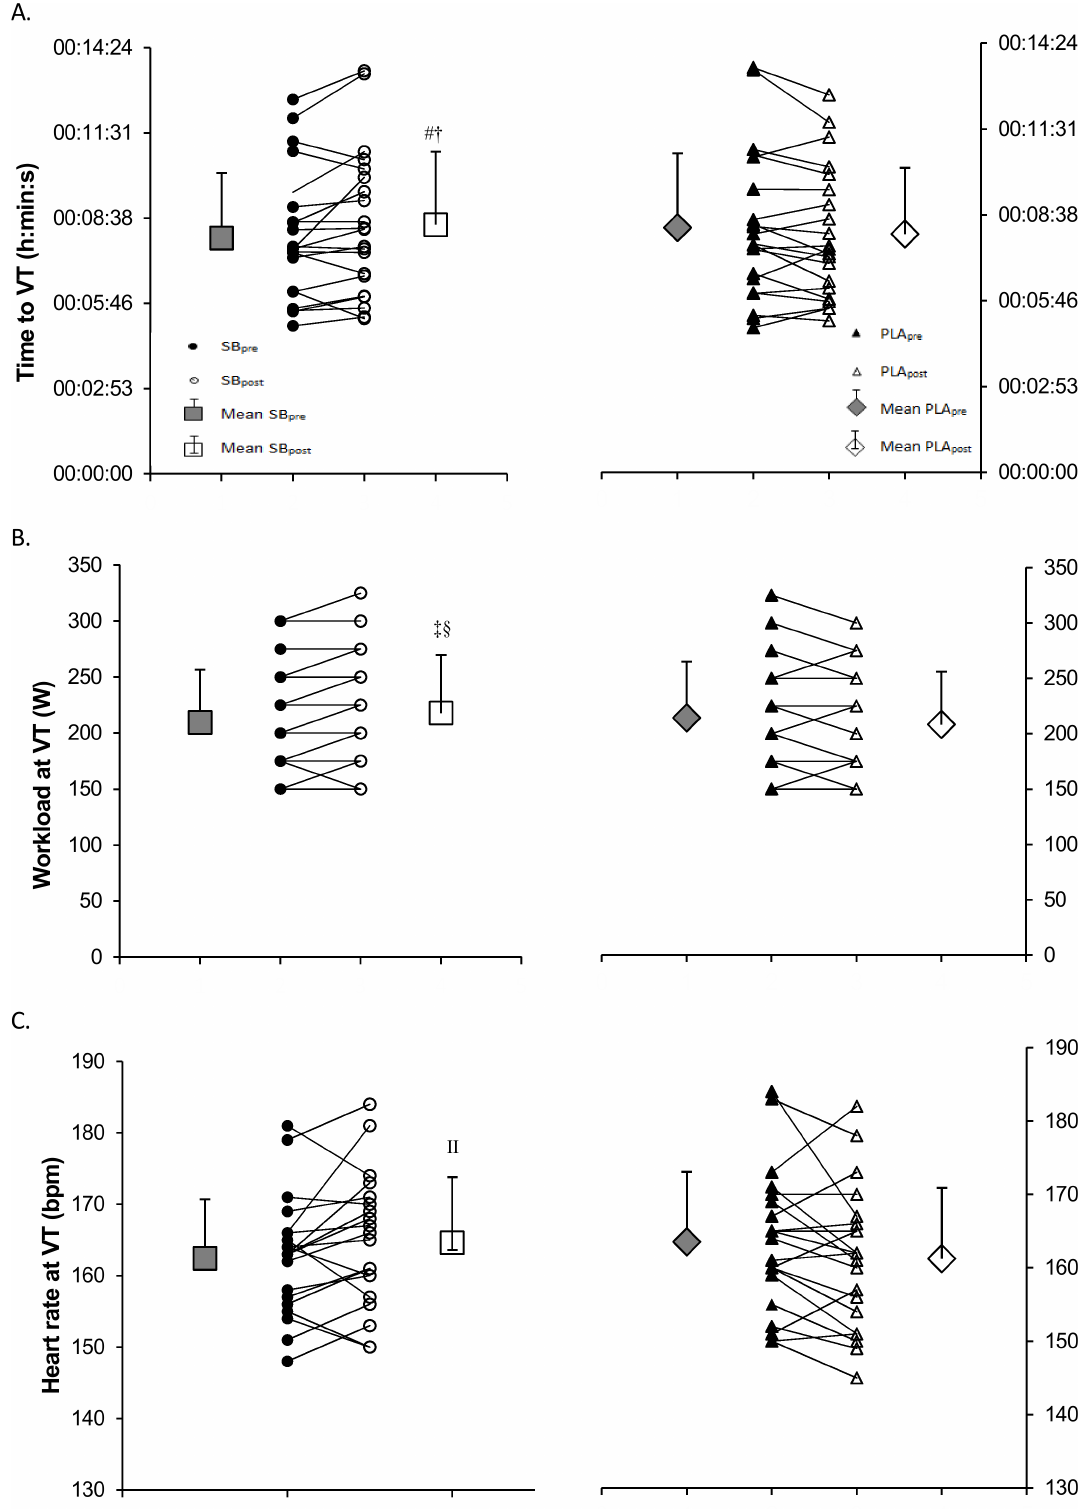
Fig 4. Ventilatory threshold in incremental cycling test. Panel A—time to VT, panel B -workload at VT and panel C—heart rate at VT. Significantly different from SB pre : # p = 0.027 (time to VT), ‡ p = 0.028 (workload at VT); significantly different from PLA post : † p = 0.020 (time to VT), § p = 0.014 (workload at VT), II p = 0.020 (heart rate at VT). https://doi.org/10.1371/journal.pone.0197480.g004 PLOS ONE | https://doi.org/10.1371/journal.pone.0197480 May 17,